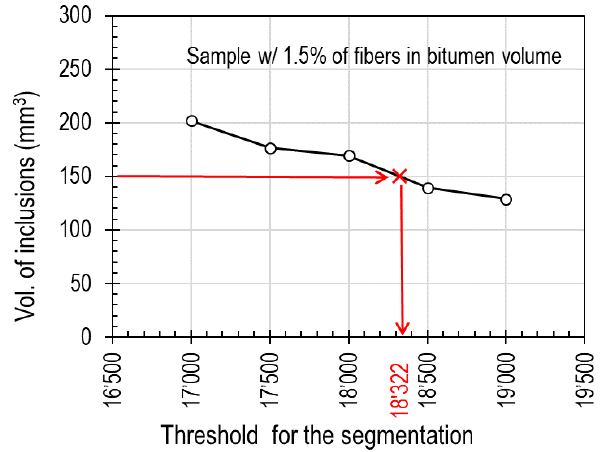
Figure 6. ( a ) Overview the geometrical parameters of the inclusions, in red the values set to filter out the aggregate’s inclusions. ( b ) View of the inclusions after segmentation and filtering.